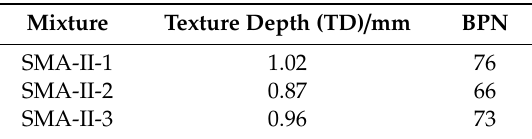
Table 18. Test results of skid resistance